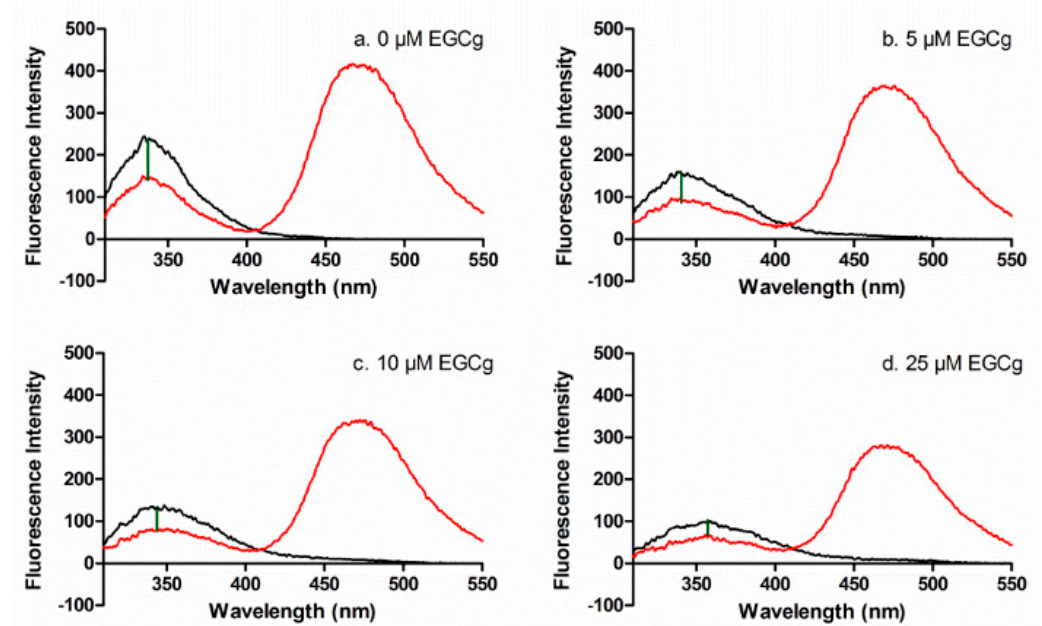
Figure 3. Fluorescence emission spectra for 1 μ M HSA (black) and HSA-CPM (red) with 0 μ M ( a ), 5 μ M ( b ), 10 μ M ( c ), 25 μ M ( d ) EGCg. The difference in intensity at 340 nm ( ∆ em ) between HSA and HSA-CPM (green line) indicates the energy transfer.